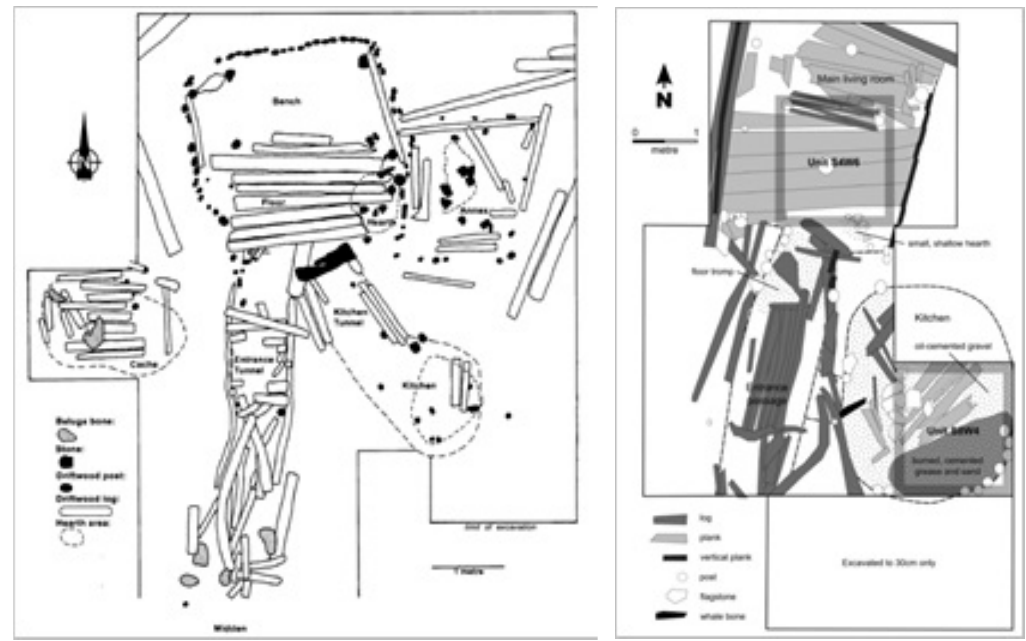
Figure 9: Cache Point, House 8 (from Friesen and Betts 2006: 67).